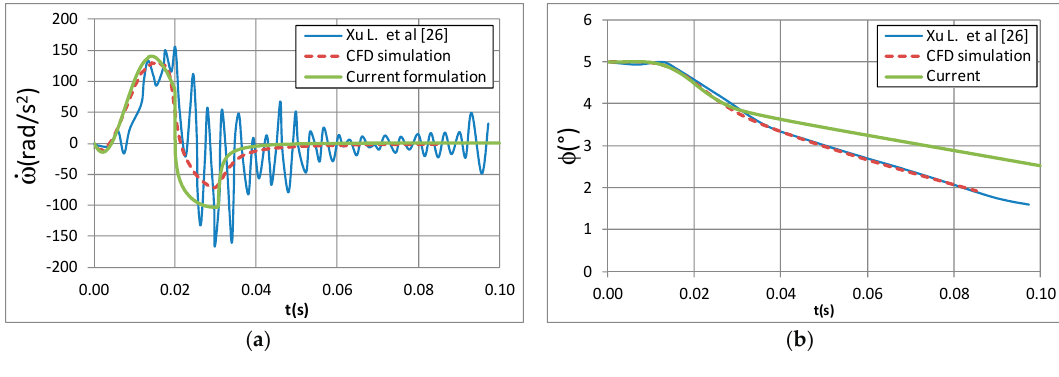
Figure 14. Pressure distribution during the impact with three degrees of freedom, w = 5 m/s, v = 5 m/s, ω = − 2.5 rad/s, β = 45°, Vcg = 0.25 m, and φ 0 = − 10°. ( a ) z 0 = 0.3 m. ( b ) z 0 = 0.4 m. ( c ) z 0 = 0.5 m. ( d ) z 0 = 0.6 m.